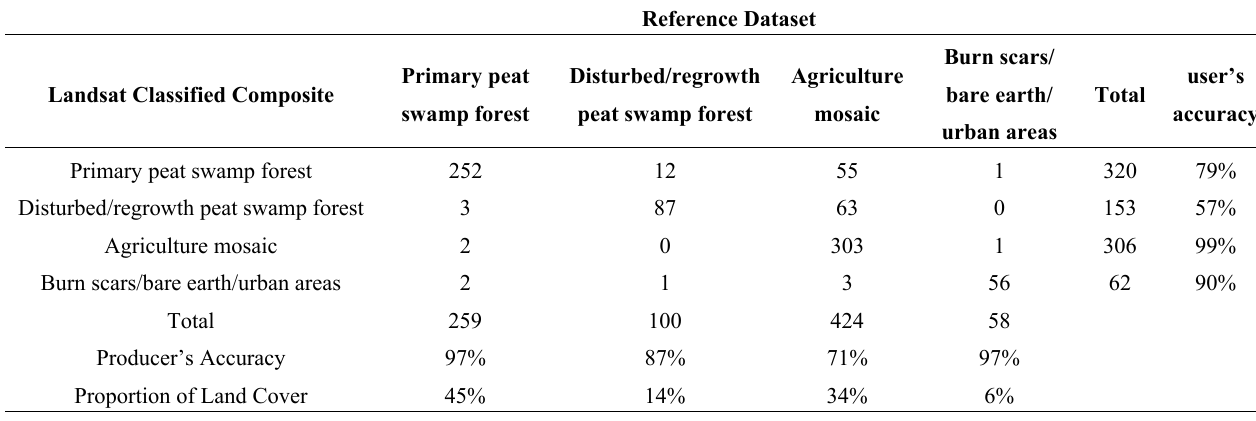
Table 4. Confusion matrix for 2010 peat swamp forest-cover composite in